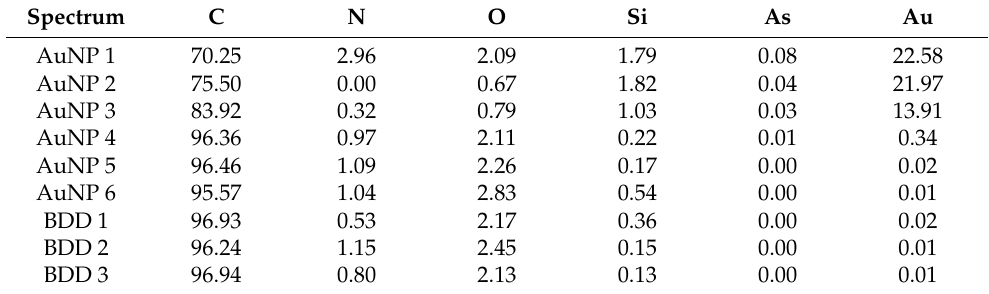
Table 2. Measurement of the atomic ratios (%) by point analysis using energy-dispersive X-ray spectroscopy. Spectrum C N O Si As AuNP